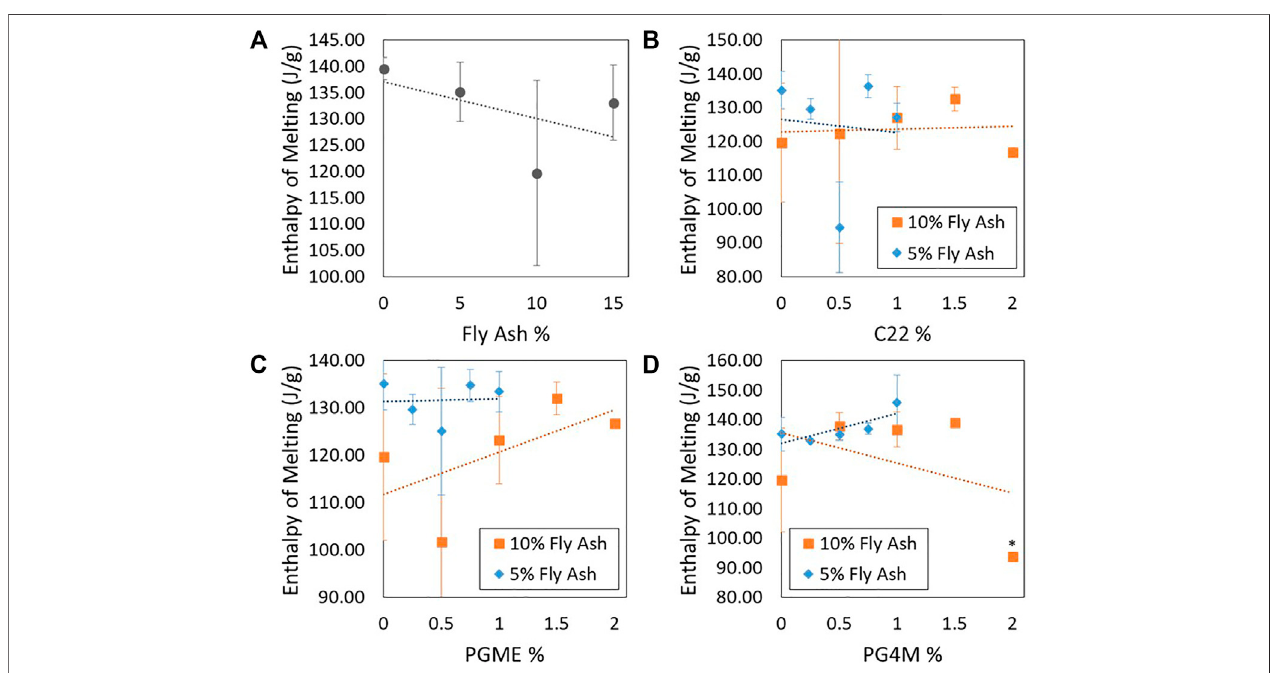
FIGURE 7 | Enthalpy of melting data for (A) PCR LLDPE-FA blends without compatibilizer, (B) blends with C22, (C) blends with PGME, (D) blends with PG4M.